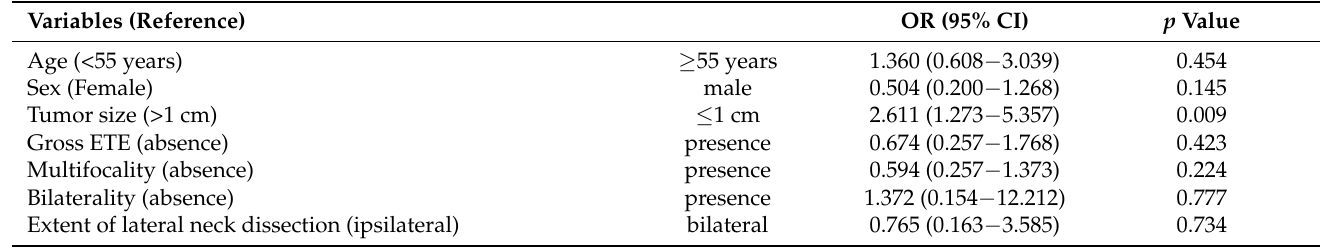
Table 3. Multivariate logistic regression analyses for the prediction of skip